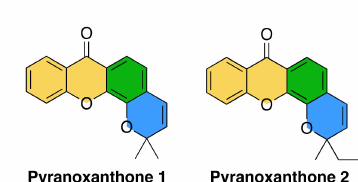
Figure 1. Structure of pyranoxanthone 1 and 2 . The xanthone sca ff old is highlighted in yellow and green and the benzopyran sca ff old is highlighted in green and